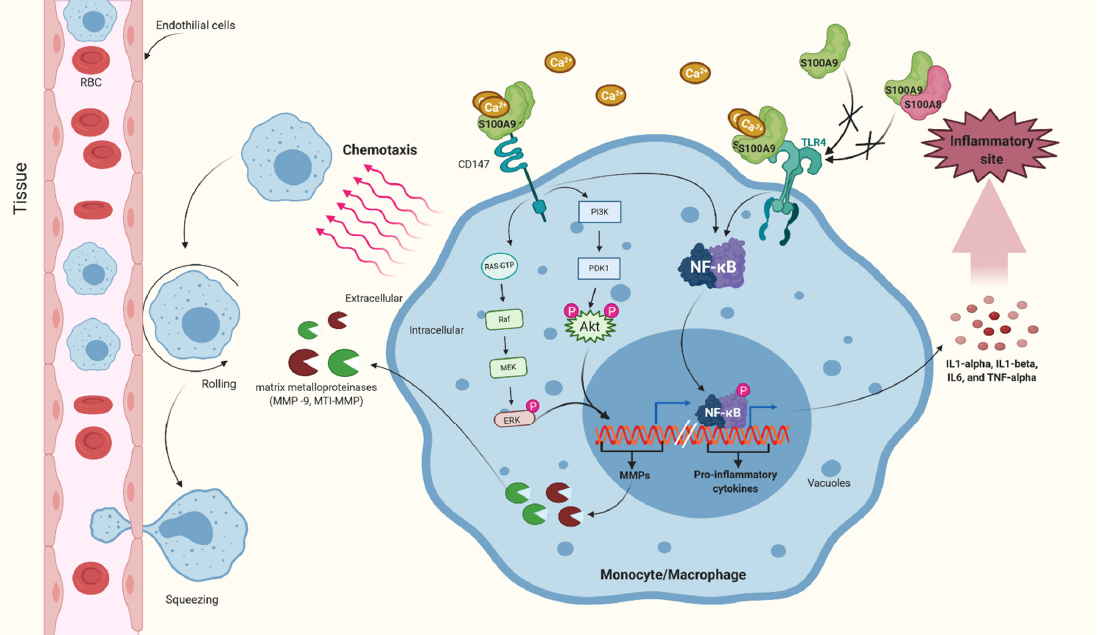
Figure 3. The image depicts the S100 isoform, S100A9, which stimulates the release of pro-inflam- matory cytokines by binding to the TLR-4 receptor, which activates the NF- κ B transcription factor, resulting in the expression of pro-inflammatory response genes in monocytes. Created with BioRen- der.com.